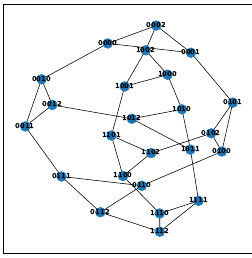
Figure 5. BC 2,2 structure.